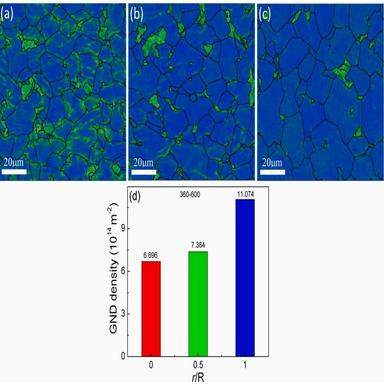
EBSD KAM images of 360–600 sample at (a) r = 1.0 R, (b) r = 0.5 R, (c) r = 0 R, and (d) GNDs versus radius.